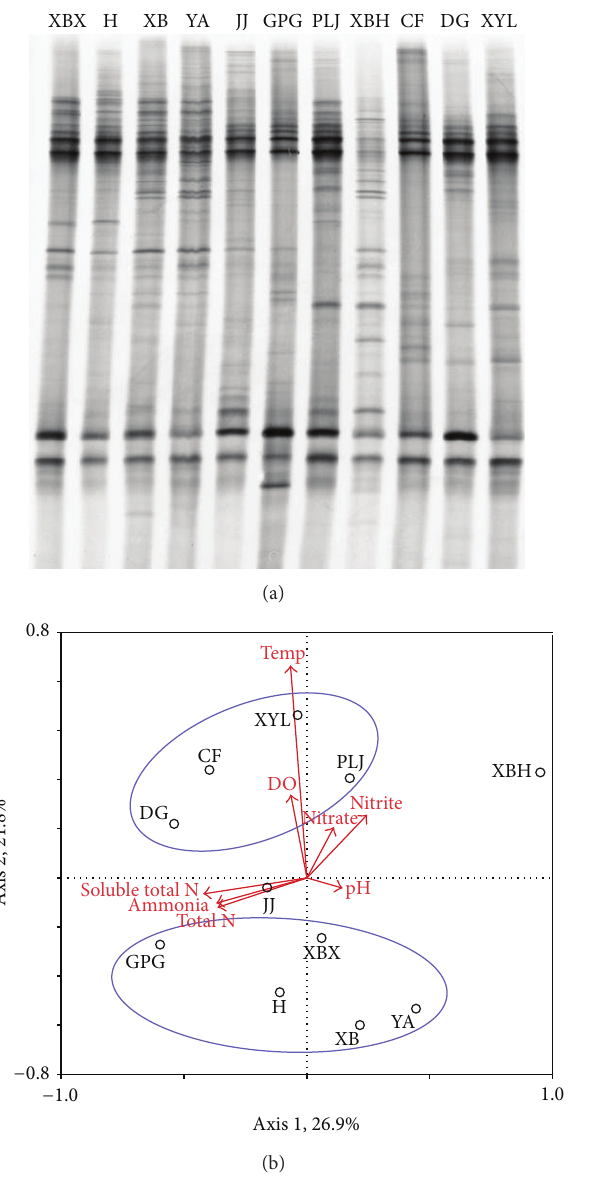
Figure4:DGGEfingerprintsandtheredundancyanalysisofDGGE band data of nirK gene. Arrows represent quantitative variables of environmental variables and small circles with letters represent the name of sample rivers; river names: XBX = Xinbaoxiang, DG = Daguang, CF = Chuangfang, PLJ = Panlongjiang, H = Haiheriver, GPG = Guangpugou, JJ = Jinjia, XBH = Xibahe, XYL = Xinyunling, XB = Xiaba, and YA = Yaoan.